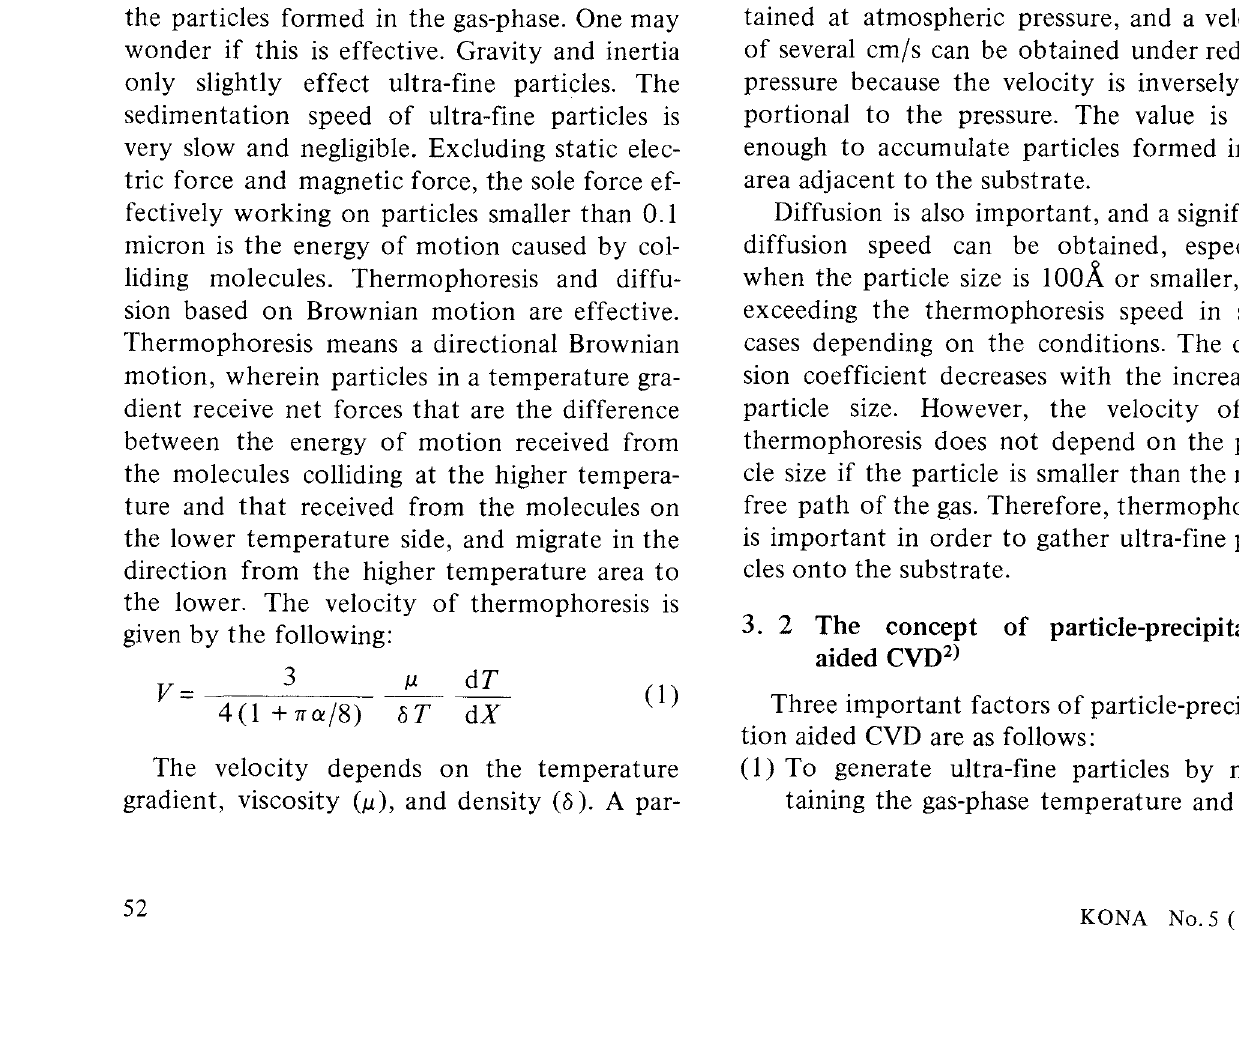
Fig. 4 Brown movements of ultra-fine particles in an isothermal system and in an athermal